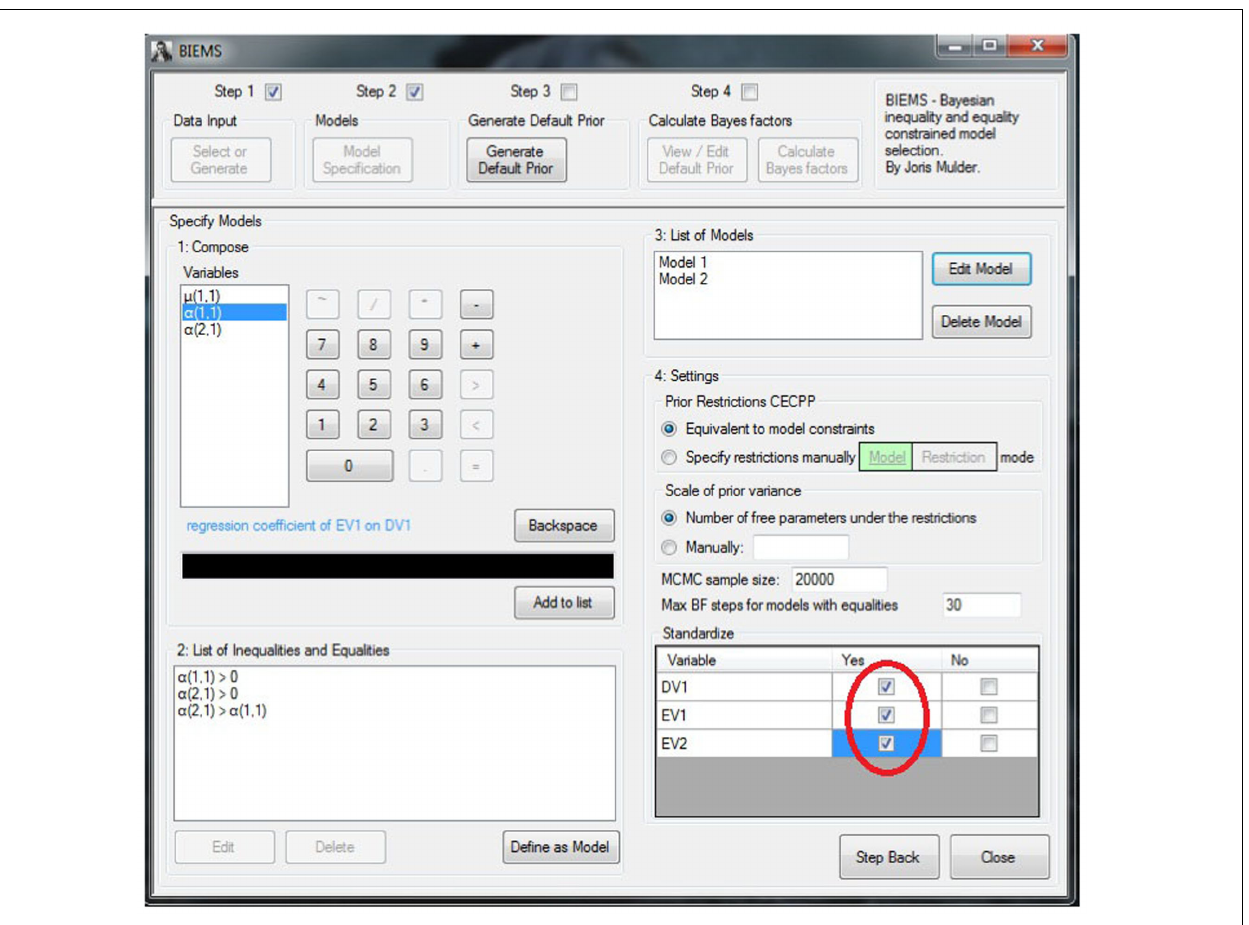
FIGURE 3 | Specifying hypothesis 3 in